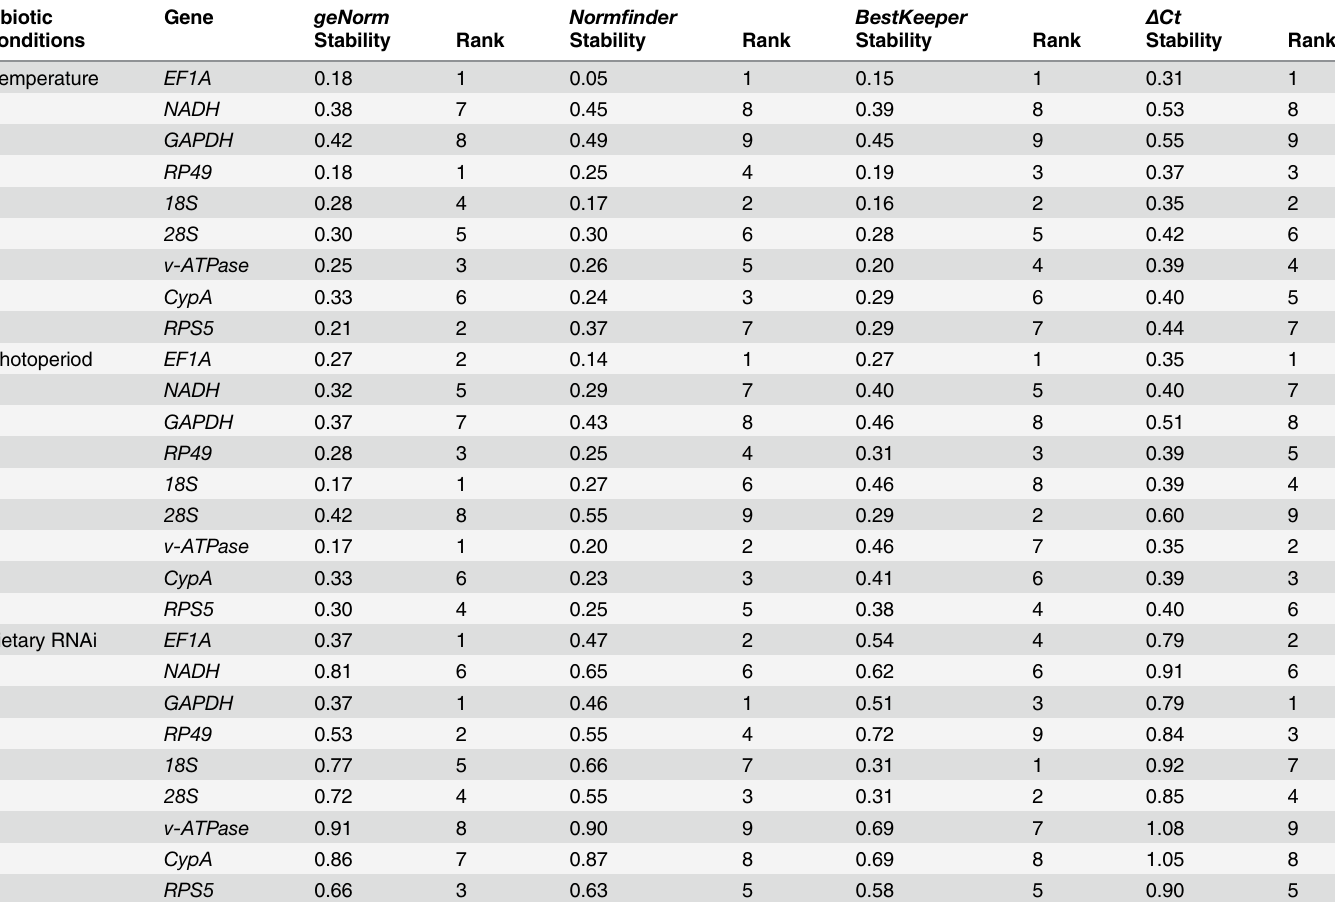
Table 3. Stability of reference gene expression under abiotic